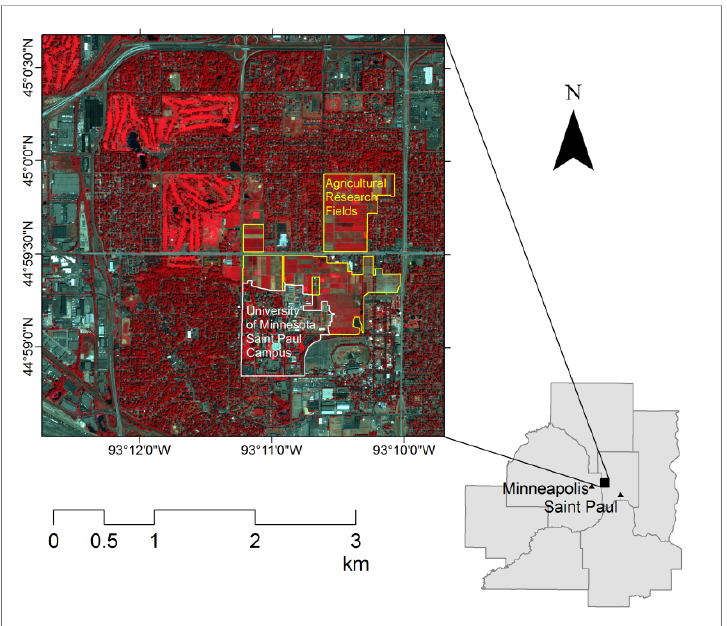
Figure 1. The geographical location of the study site, which includes the University of Minnesota Saint Paul campus, and the near infrared false color composite QuickBird imagery (acquired on 18 August 2003) of the suburban area in the Twin Cities Metropolitan Area, MN,